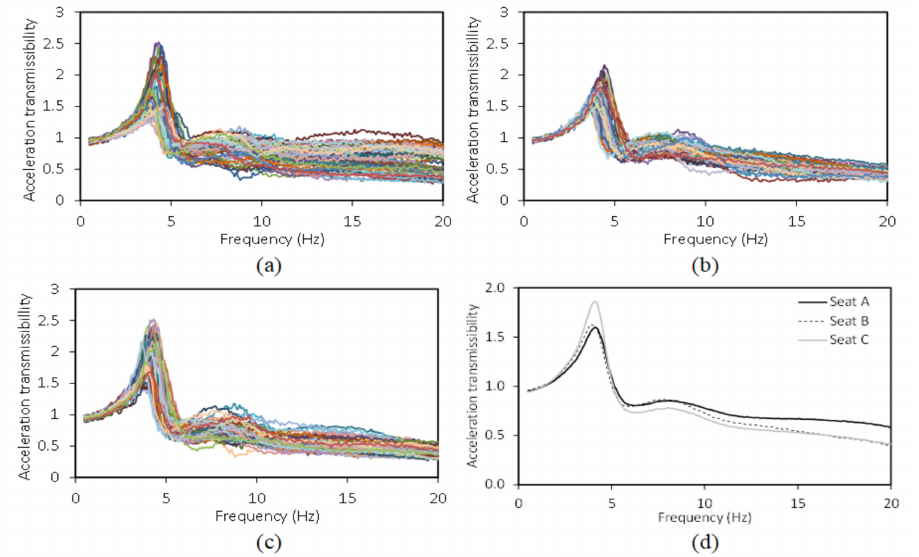
Figure 3. Acceleration transmissibility of three seats with 58 participants seated without back support under 0.50 m/s 2 RMS excitation at the body-seat interface: ( a ) seat A; ( b ) seat B; ( c ) seat C; and ( d ) mean acceleration